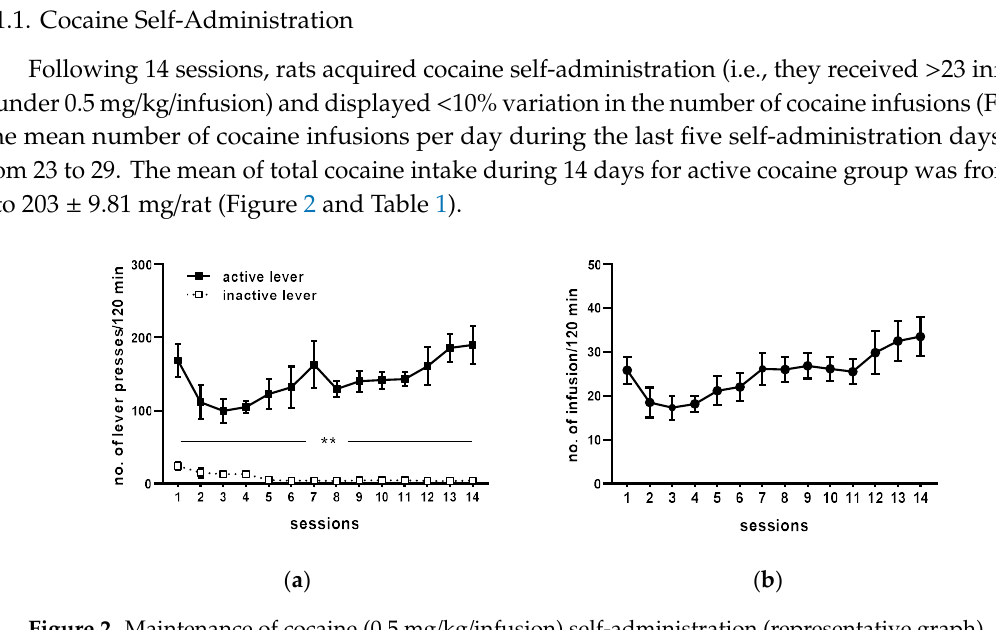
Figure 2. Maintenance of cocaine (0.5 mg/kg/infusion) self-administration (representative graph). All data are expressed as means ± SEM. N = 6 rats/group. ** p < 0.01 vs. inactive lever. ( a ), numbers of active and inactive lever presses; ( b ), numbers of cocaine infusions. Table 1. Cocaine (0.5 mg / kg / infusion) self-administration. Presses on the levers and cocaine infusion. Number of Active Lever Inactive Lever Infusion Future cocaine abstinence in an enriched